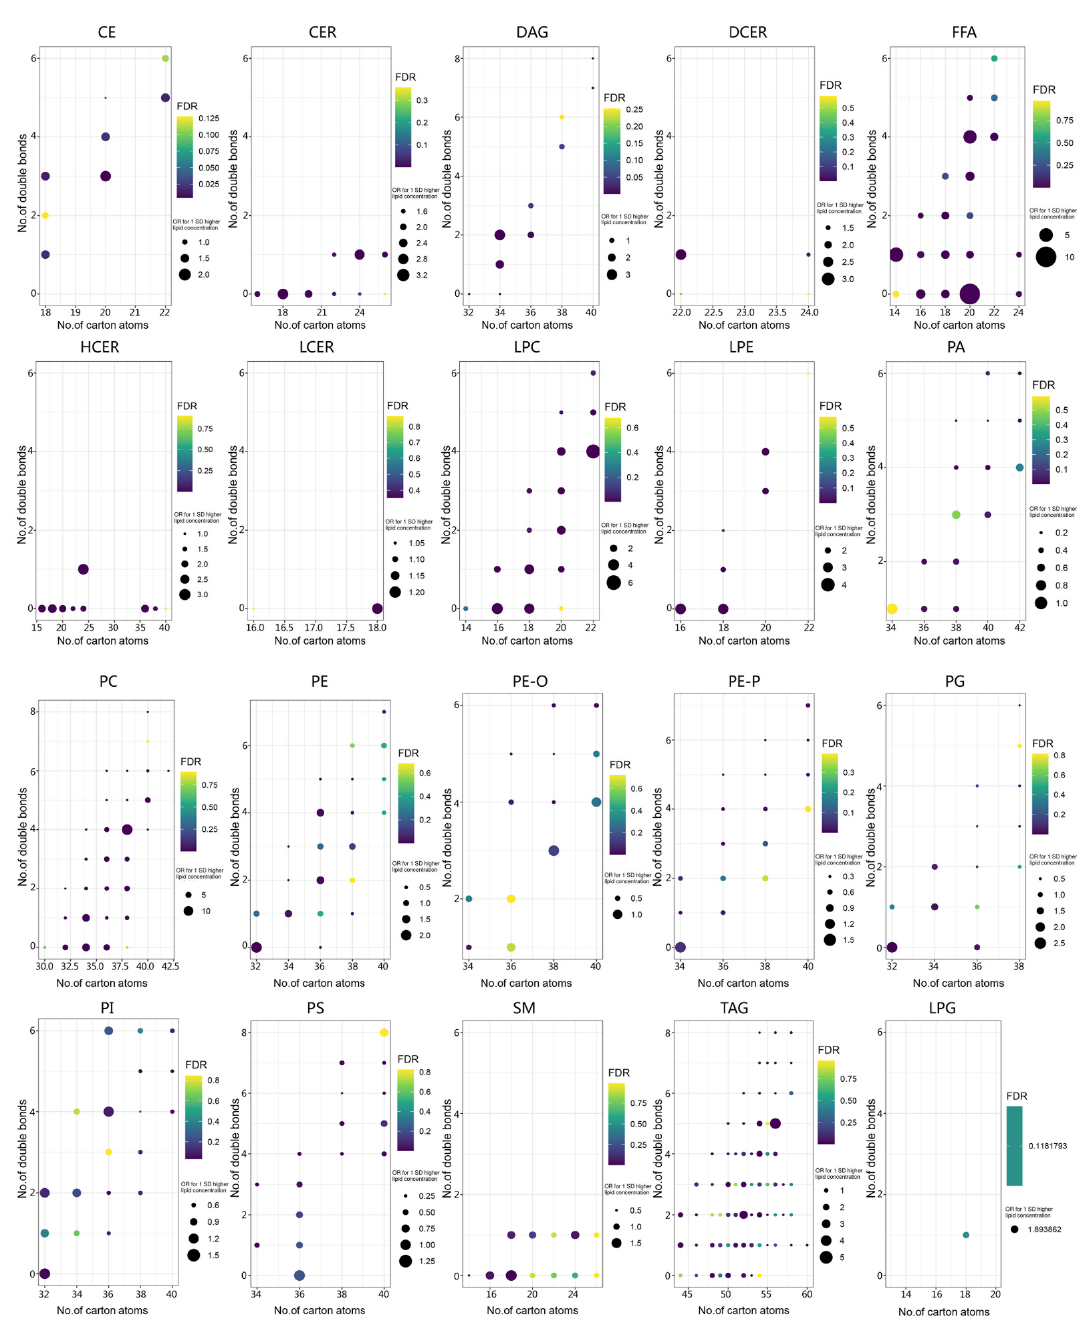
Figure 1. Association of fatty acid chain length and saturation level with LC risk by different lipid classes or subclasses through multivariable-adjusted conditional logistic regression. The x -axis denotes the total number of acyl-chain carbon atoms. The y -axis denotes the number of double bonds in the acyl chain. Circle size refers to the significance level indicated by p value and circle color refers to the magnitude of the OR per 1-SD (log scale) increment.